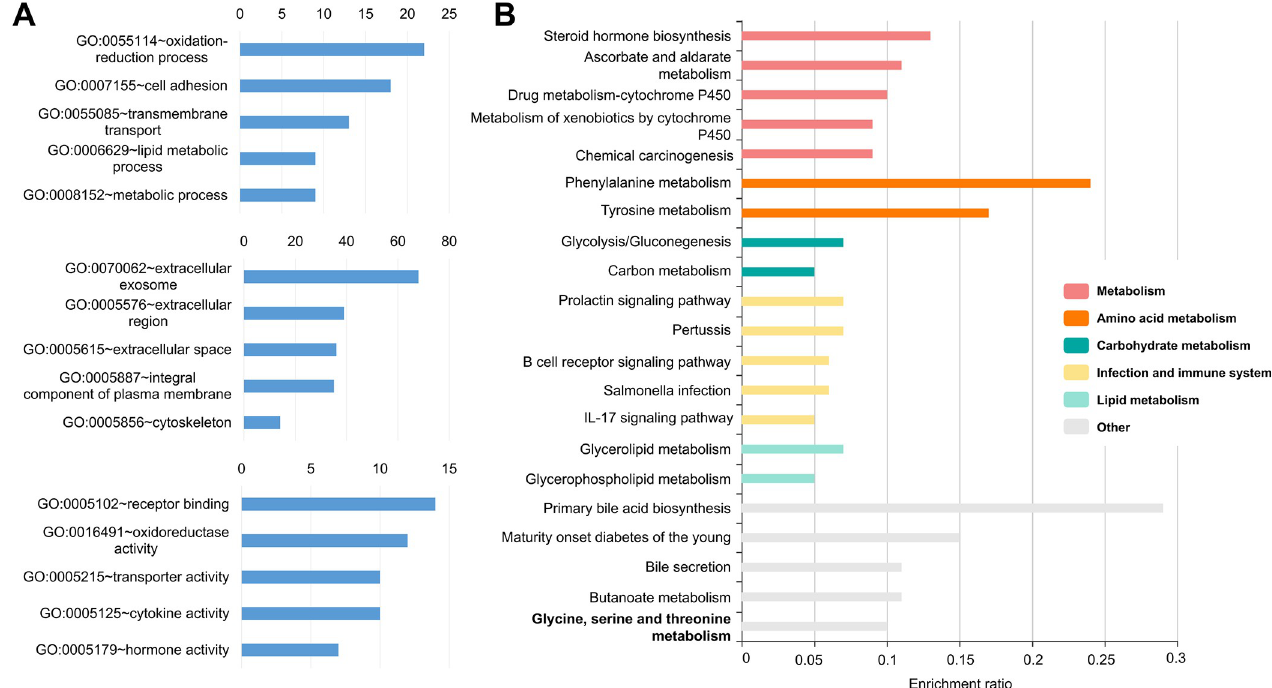
Fig 3. Functional annotation and pathway enrichment analysis of commonly expressed DEmRNAs treated with BET inhibitors. (A) GO term analysis of commonly expressed DEmRNAs. The numbers of genes enriched for each term are displayed for the top 5 GO terms in biological process (BP; upper panel), cellular component (CC; middle panel), and molecular function (MF; bottom panel). (B) KEGG pathway enrichment analysis of commonly expressed DEmRNAs. Each row represents an enriched function, and the length of the bar represents the enrichment ratio, which is calculated as input gene number/ background gene number (KOBAS, http://kobas.cbi.pku.edu.cn). In the KOBAS algorithm, clusters are divided according to the values calculated for the enriched terms. The colors of the bars represent different clusters and show the top 5 with the highest enrichment ratios.